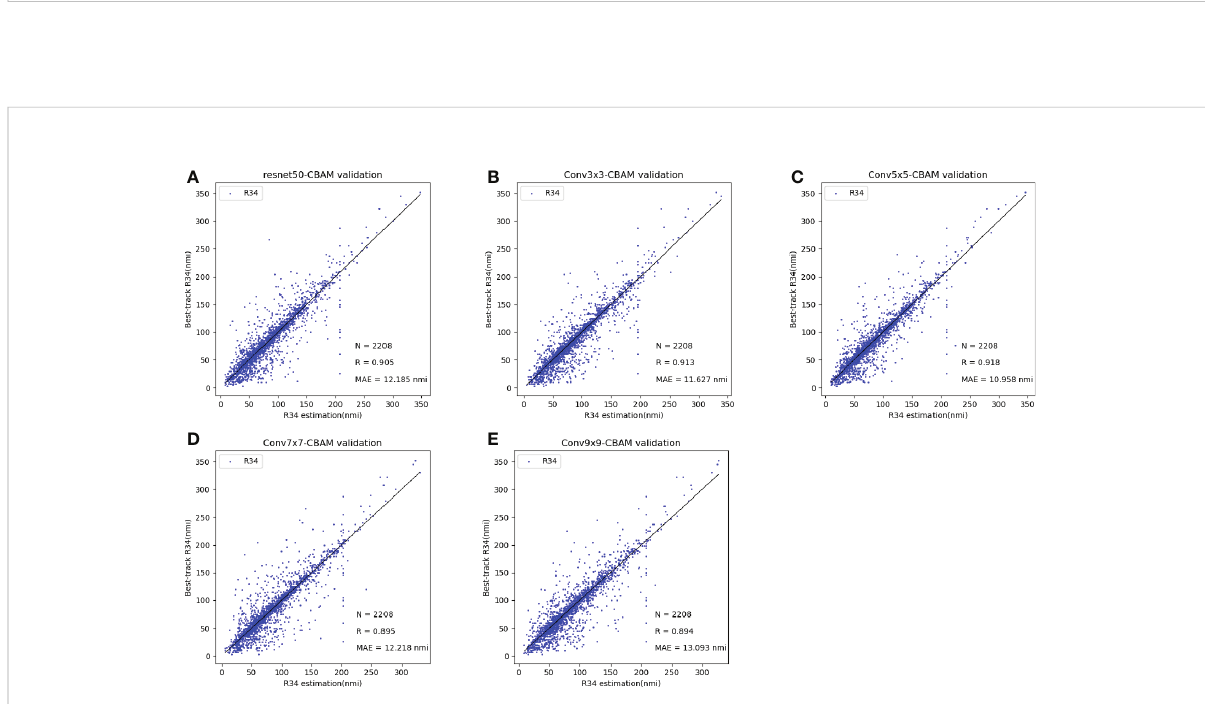
FIGURE 12 Scatterplot of results obtained after incorporation of attention mechanism (CBAM) based on Figure 11. (A) Unimproved residual blocks, (B) with added 3 × 3 convolution kernel, (C) with added 5 × 5 convolution kernel, (D) with added 7 × 7 convolution kernel, and (E) with added 9 × 9 convolution kernel. In each fi gure, the horizontal axis is the R34 estimation of the model output, the vertical axis is the corresponding label, and the bottom-right corner shows the N, R, and MAE values.